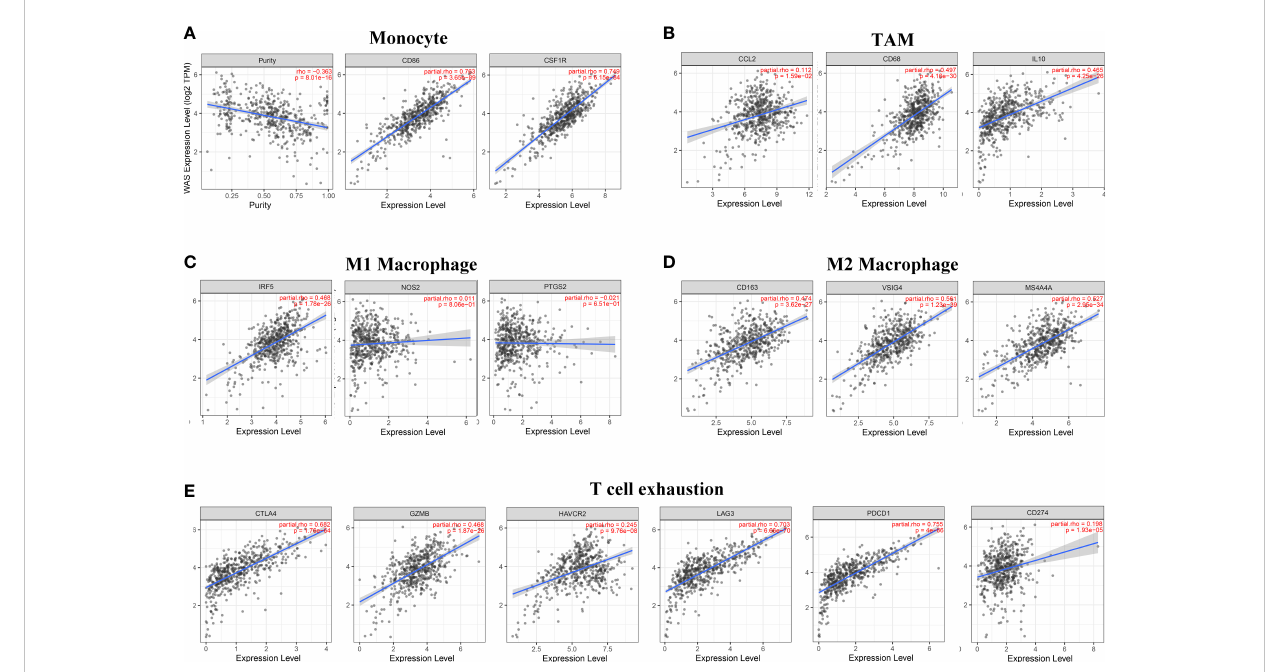
FIGURE 7 WAS expression is associated with macrophage, monocyte, and T cell exhaustion in clear cell renal cell carcinoma (ccRCC). Markers include CSF1R and CD86 of monocytes; CD68, IL10 and CCL2 of TAM; PTGS2, IRF5 and NOS2 of M1 macrophages; CD163, VSIG4 and MS4A4A of M2 macrophages; and PD-1, PD-L1, CTLA4, LAG3, TIM-3 and GZMB of T cell exhaustion. The following scatterplots illustrate the correlations between WAS expression and gene markers of monocytes (A) and TAMs (B) as well as M1 (C) and M2 macrophages (D) and T-cell exhaustion (E) in ccRCC.